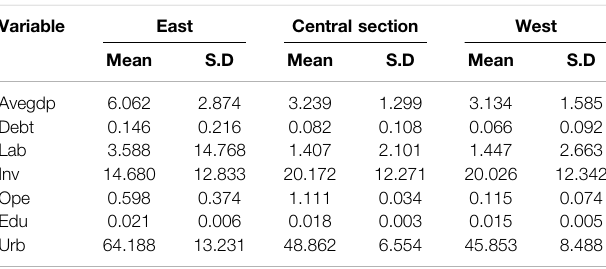
TABLE 5 | Descriptive statistical analysis of eastern, central, and western regions of China. Variable East